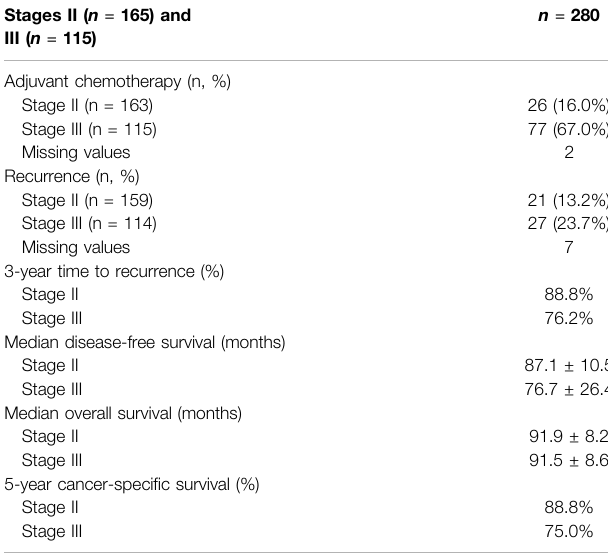
TABLE 2 | Treatments and outcome in stages II and III with curative